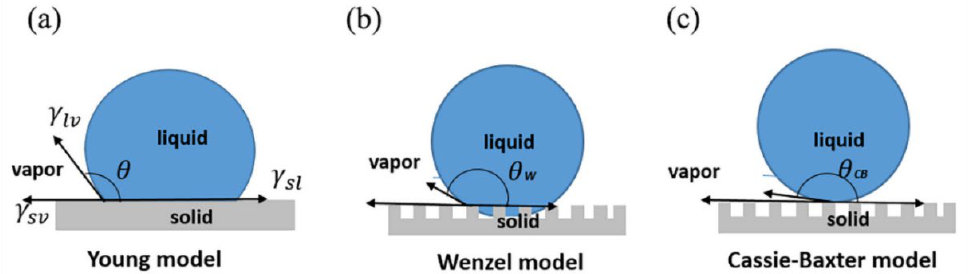
Figure 1. Various states of droplet on a solid surface. ( a ) Young model, ( b ) Wenzel model, and ( c ) Cassie–Baxter model.